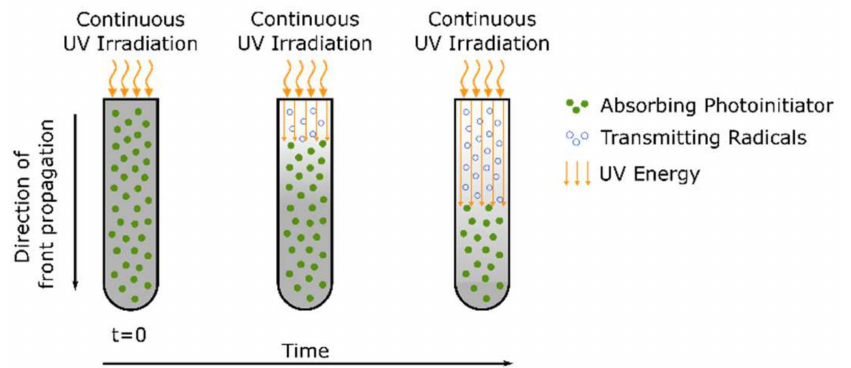
Figure 33. Schematic representation of photofrontal polymerizations showing the photobleaching effect during light